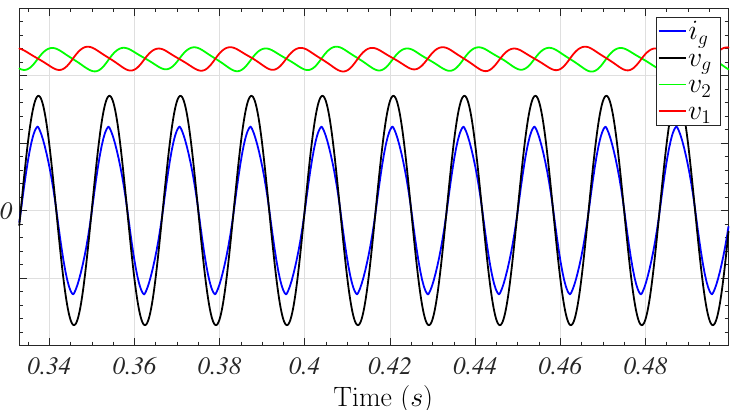
Figure 16. Waveforms obtained for CV1; i g : 1 A/div, v g , v 1 and v 2 : 100 V/div.